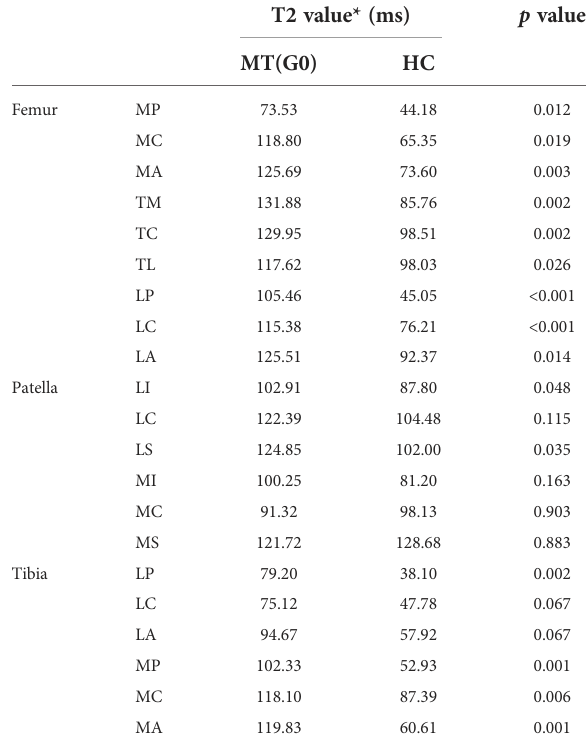
TABLE 5 Comparison of T2 values of the articular cartilage 21 subregion between the meniscus tear group Grade 0 subgroup and the healthy control group.